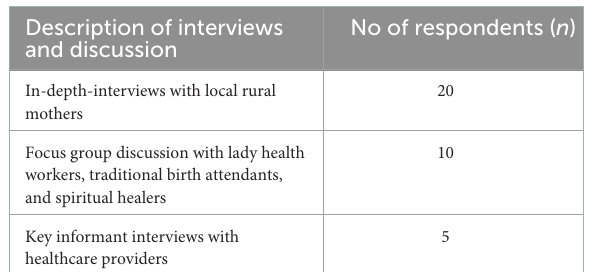
TABLE 1 Respondents information ( n = 35).